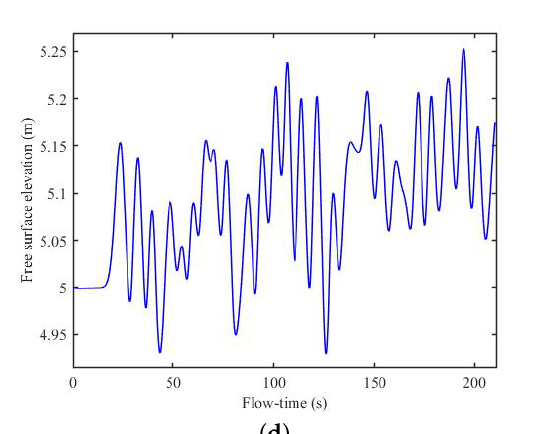
Figure 13. Variation in the free surface at different locations: ( a ) x = 0.5 m, ( b ) x = 72.025 m,